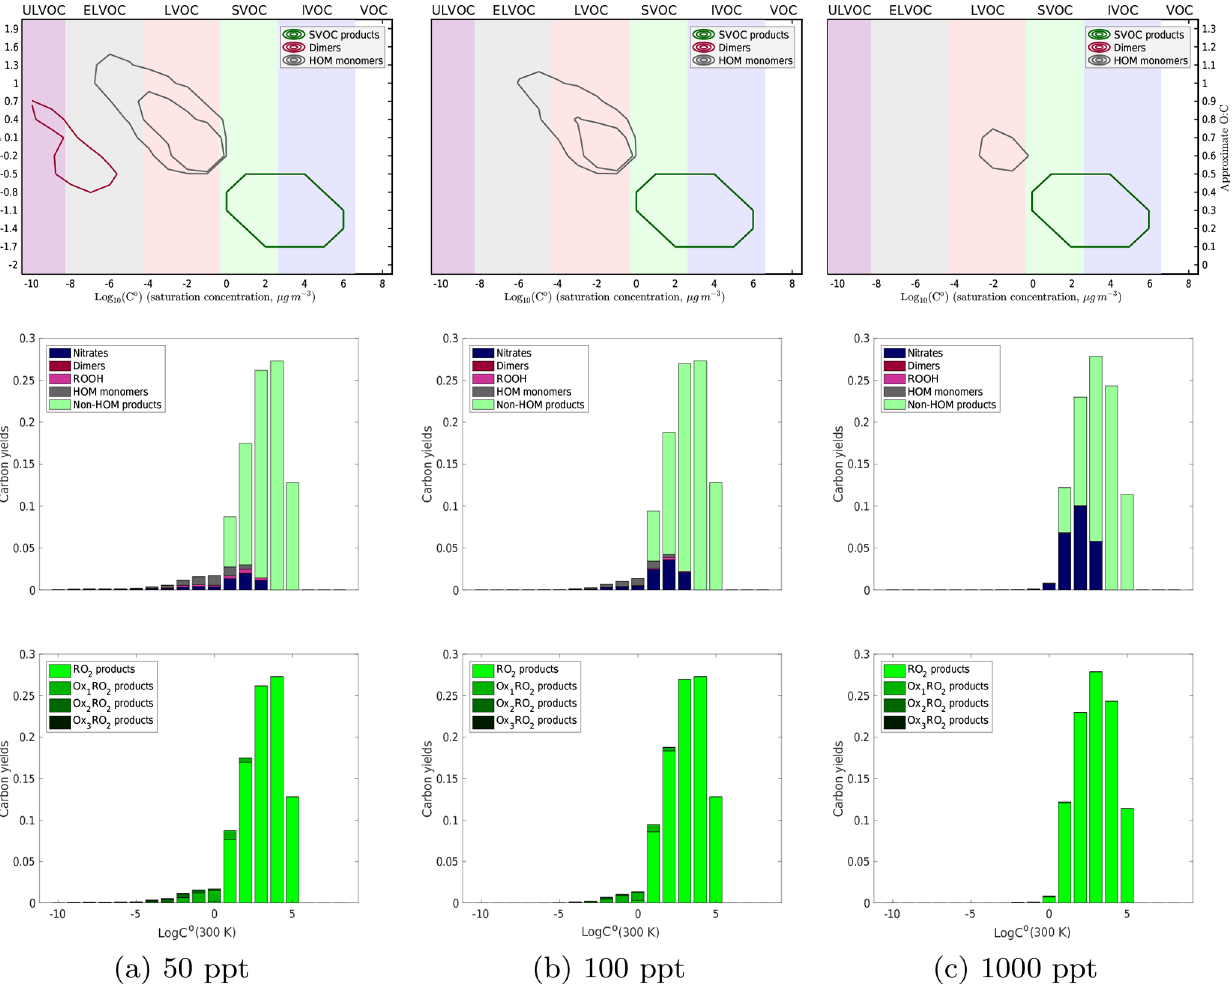
Figure 6. Yields of α -pinene oxidation products at 298K with 50, 100, and 1000ppt of NO introduced into the system. There are similar trends seen in the contour plot with an increase in the volatility of both HOM monomer and dimer products as well as a decrease in the diversity of both with increasing NO x . In the second row of plots, we see an increase in the amount of nitrates formed and the depletion of dimers formed with increasing NO x . Similarly to the temperature trend, as we increase NO x the products shift to higher volatilities. However, once we reach a high enough NO x concentration to produce essentially no dimers, we still see some LVOC products that include nitrates. This is consistent with experimental evidence that NO x suppresses nucleation but not necessarily growth. From the last plots, we can clearly see fewer autoxidation products at higher NO x concentrations with a nearly complete suppression of autoxidation between 500 and 1000ppt of NO x